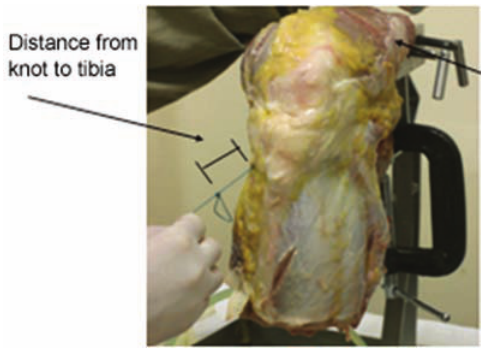
Figure 5 - Suture wire length variation. Difference in wire length between the tibial exit and the distal knot, with the knee at 90° of flexion and at total extension.